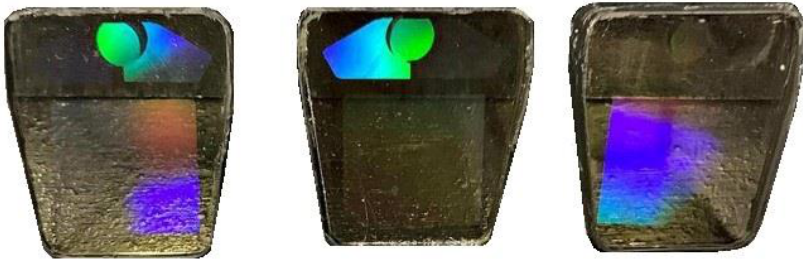
Figure 10. Photo of an experimental sample of a holographic waveguide.